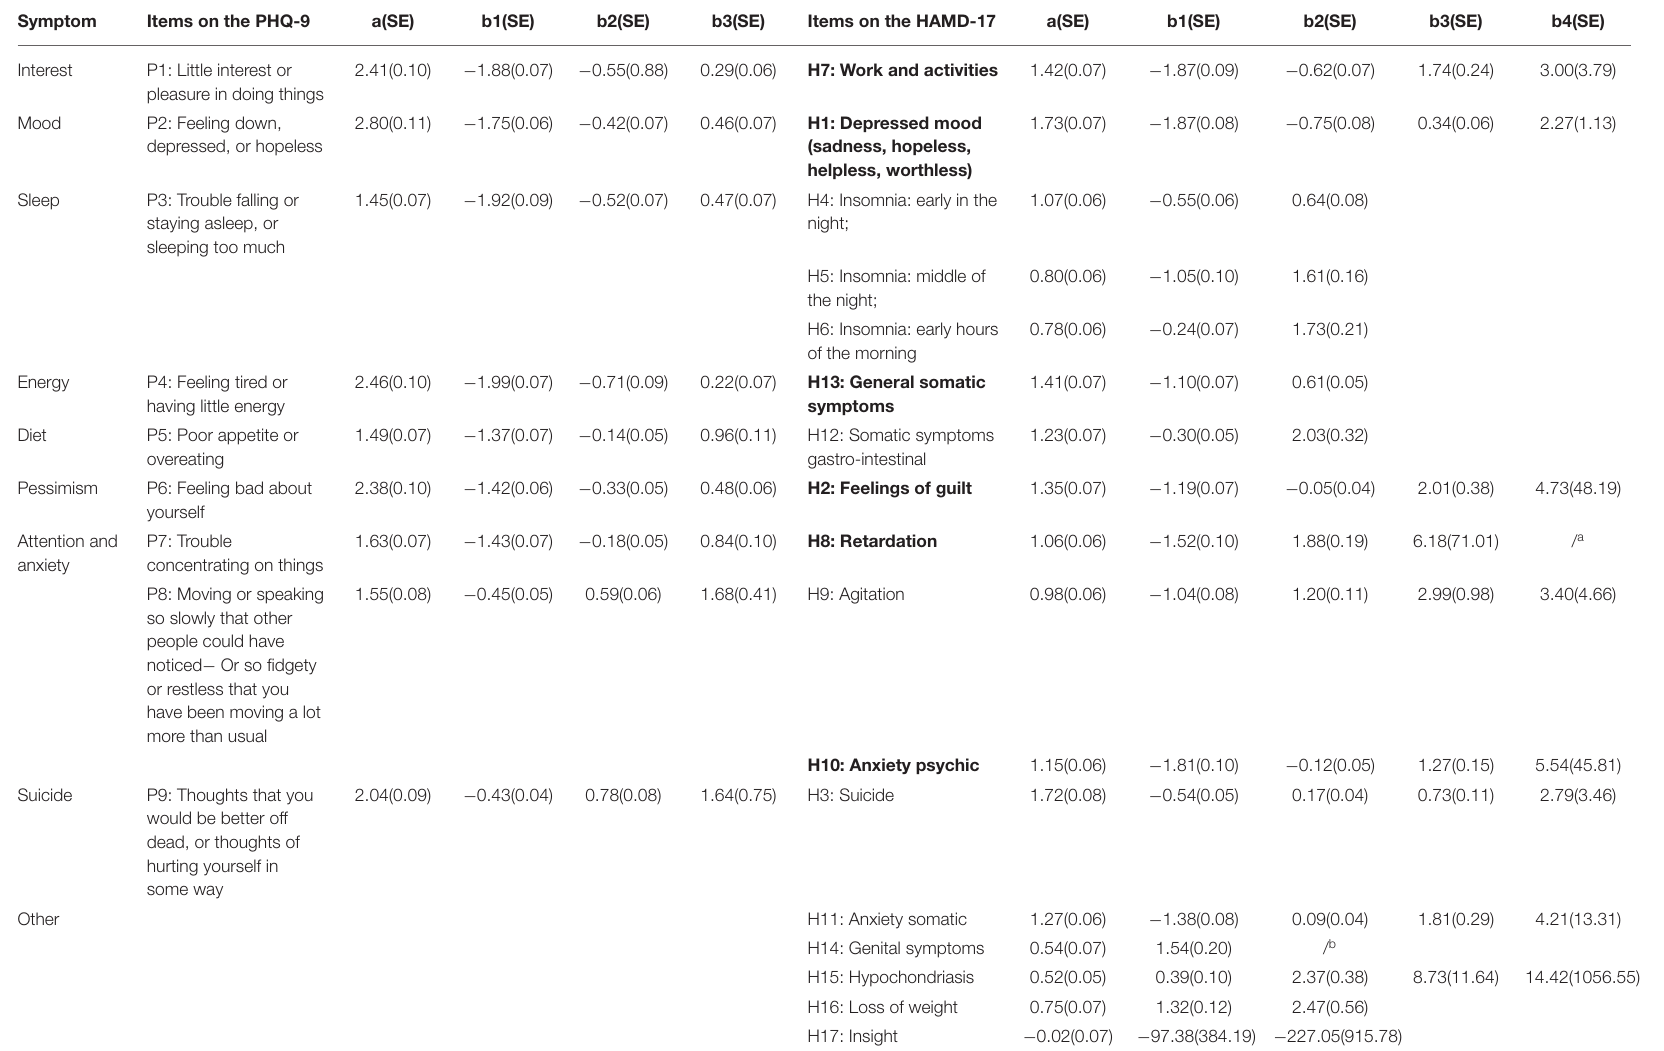
TABLE 3 | Item content and IRT item parameter